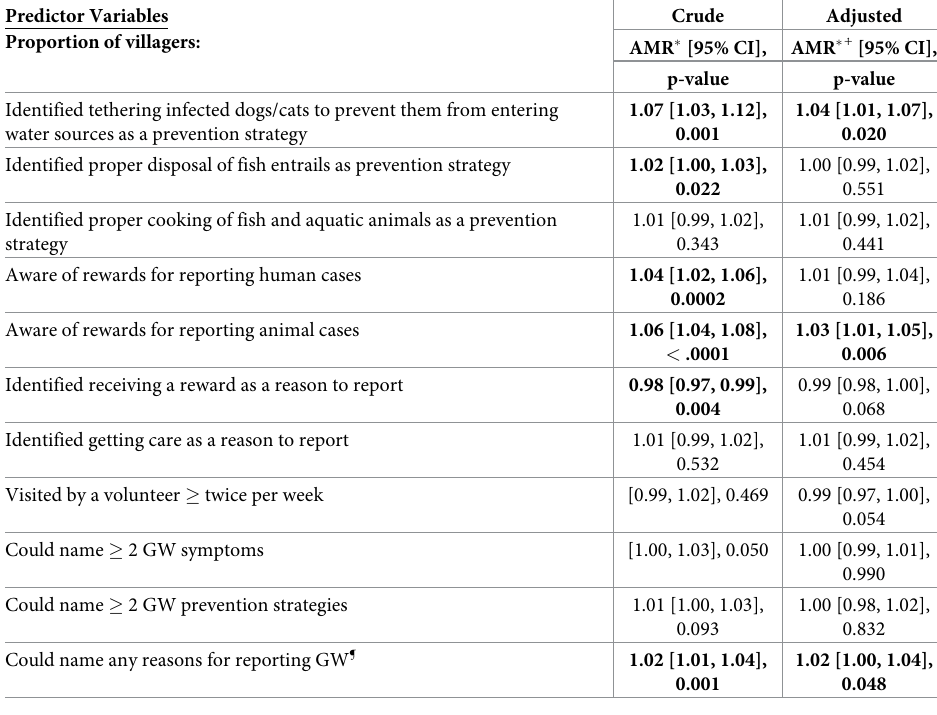
Table 3. Village-Level Models: The effect of volunteer engagement and villager knowledge on number of con- firmed canine Guinea worm cases at the village-level, January 2018–June 2019 ( n = 45 villages) in the survey to evaluate the Chad Guinea Worm Eradication Program active surveillance